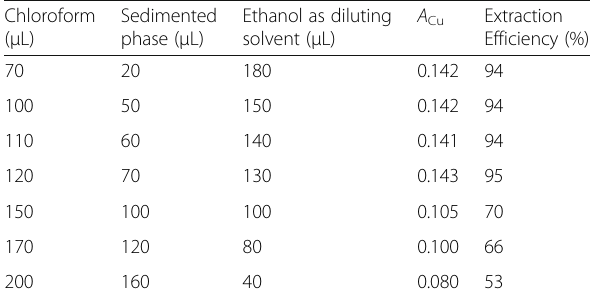
Table 1 Effect of extraction solvent (chloroform) volume on the analytical signal and extraction efficiency of copper obtained from DLLME